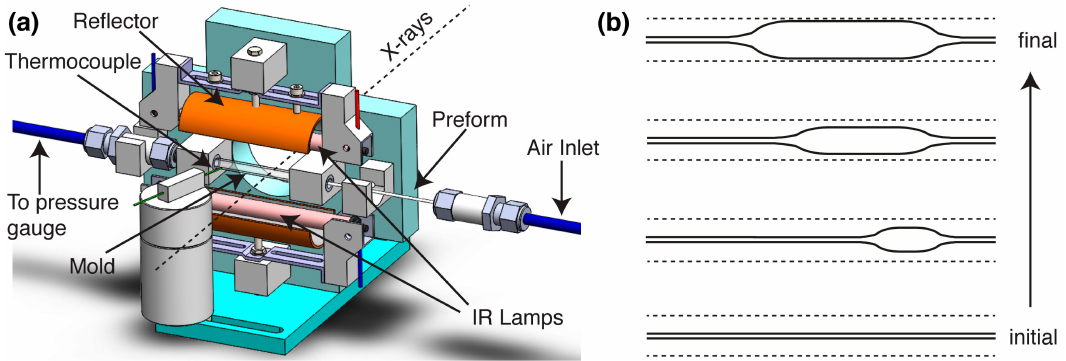
Figure 1. ( a ) A 3D diagram of the tube expansion instrument defines the positions of the IR lamps and reflectors above and below the mold, the thermocouple on the mold surface, the connection to the pressure transducer and the air inlet, and illustrates how the preform is inserted into the mold and oriented relative to the path of the X-rays. ( b ) Schematic diagram of the inflation process, which progresses from the side of tube attached to the air inlet to the opposite